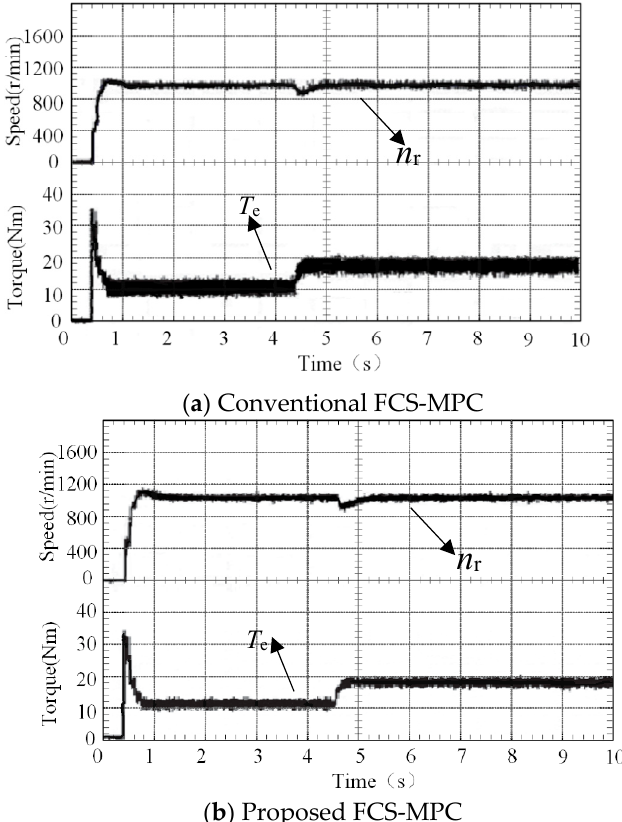
Figure 14. Speed dynamic and torque dynamic responses (IPMSM).